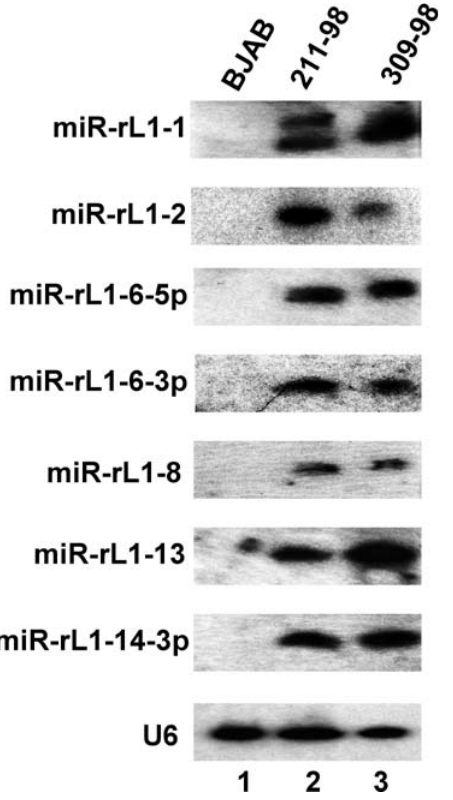
Figure 4. Analysis of rLCV miRNA Expression Northern analysis of selected rLCV miRNAs in the rLCV-infected rhesus B- cell lines 211–98 and 309–98. The human B-cell line BJAB served as a negative control. DOI: 10.1371/journal.ppat.0020023.g004